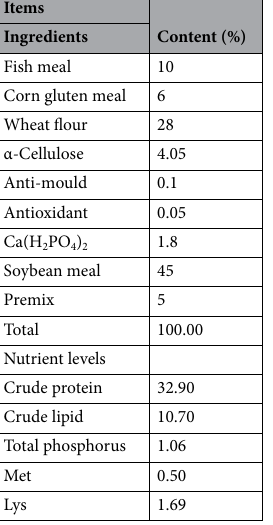
Table 1. The composition and nutrient levels of the diet (Dry matter basis) %.